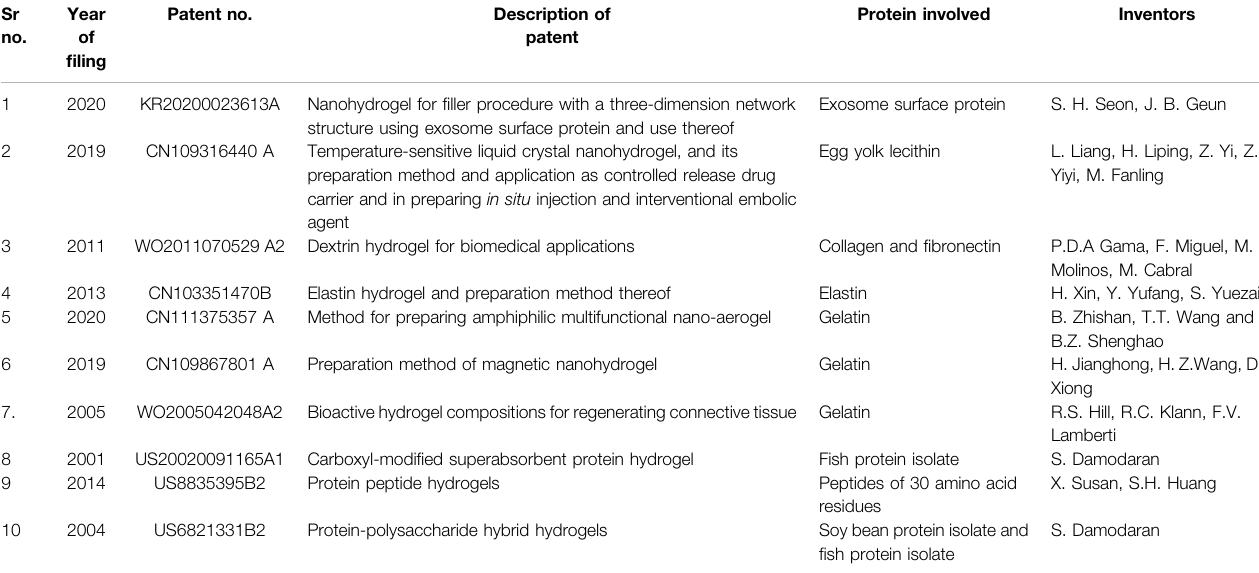
TABLE 2 | Patents fi led on protein-based nanohydrogels. Sr